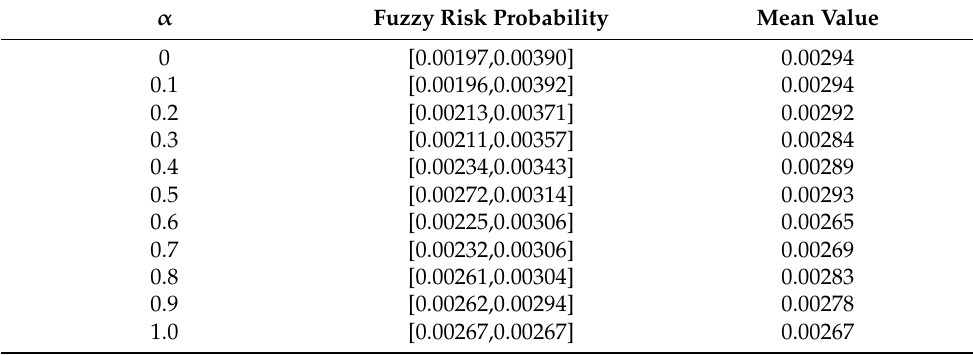
Table 7. Fuzzy risk probability value under all reservoir water